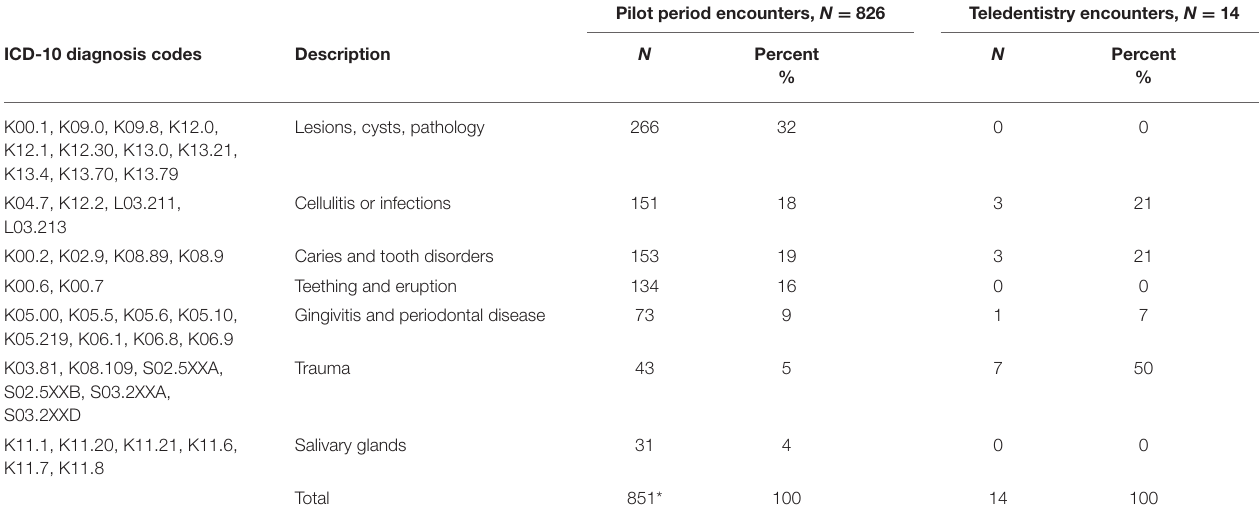
TABLE 1 | Frequency of dental diagnosis codes at five medical sites during pilot period. Pilot period encounters, N = 826 Teledentistry encounters, N =